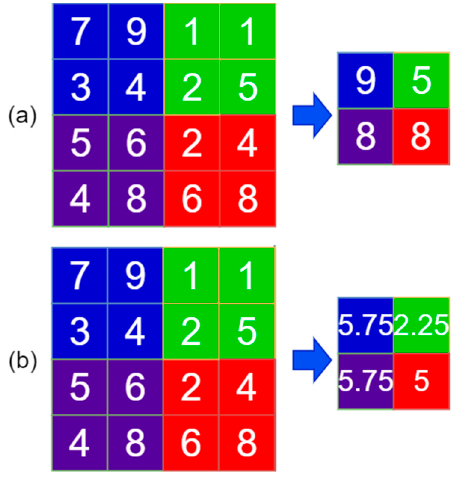
Figure 7. Pooling layer. ( a ) the maximum pooling; ( b ) the average pooling.